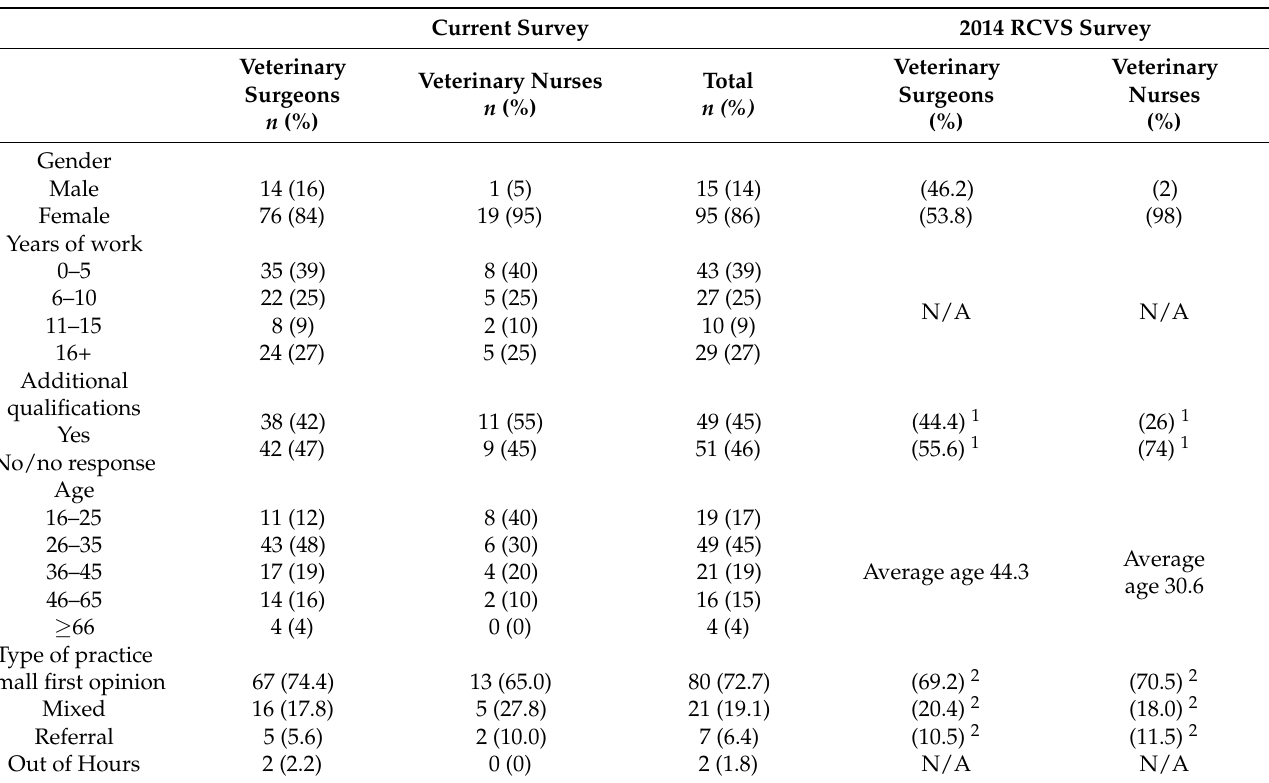
Table 1. Demographics of the veterinary professionals who completed the online questionnaire for the present study, and the corresponding demographics from the 2014 RCVS surveys of Veterinary Surgeons and